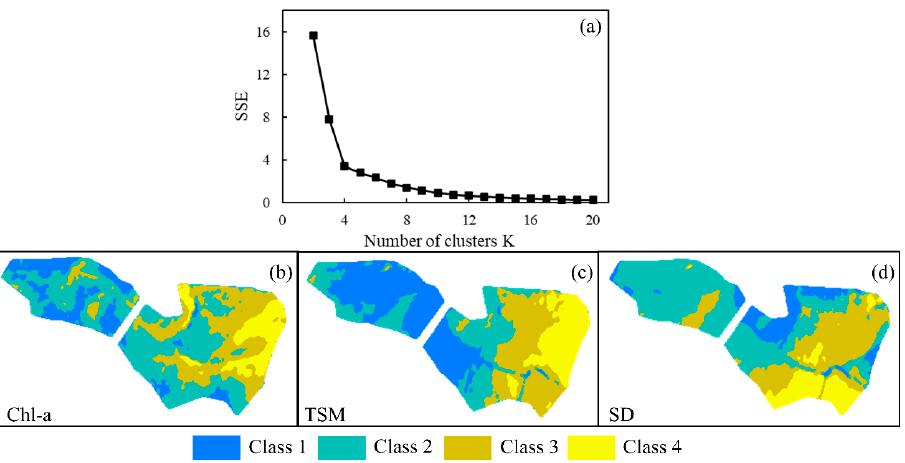
Figure 4. Variations of SSE with increasing K ( a ) and the spatial distribution of Chl-a ( b ), TSM ( c ), and SD ( d ) in Nanyi Lake.